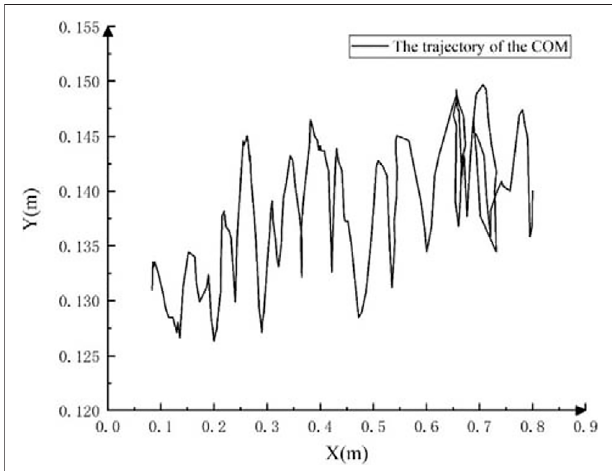
FIGURE 18 | The straight walking trajectory of the center of mass of the robot on the sandy